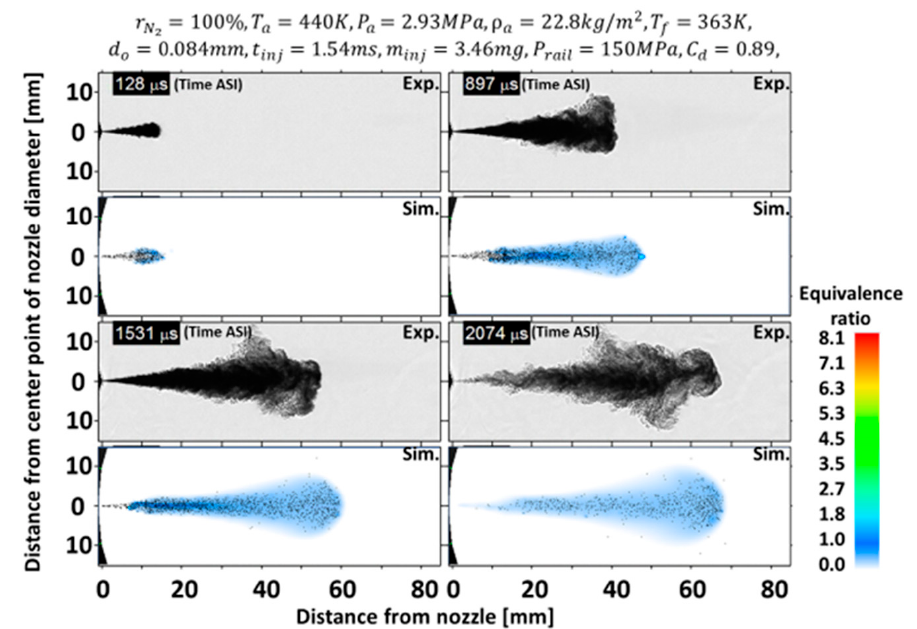
Figure 2. Comparison of the spray shapes and equivalence ratio histories of the experimental result [23] and the simulation result under an ambient temperature of 440 K.